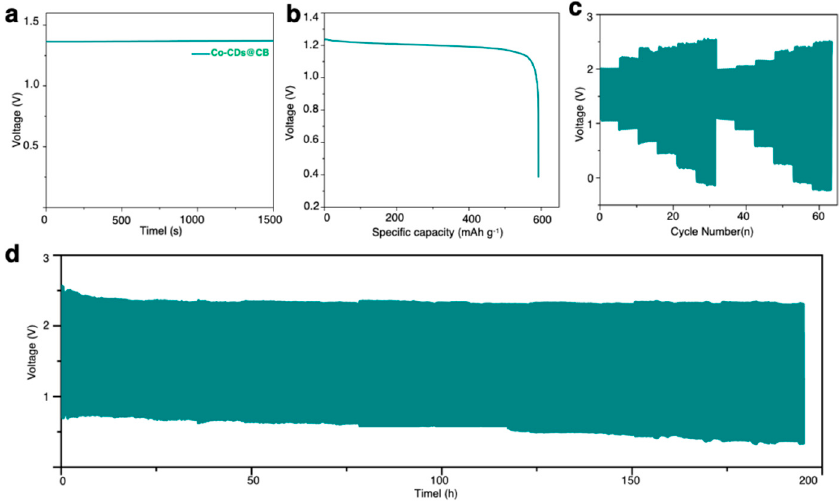
Figure 4. ( a ) Open-circuit curves plots. ( b ) Discharging capacity plots recorded under the current density of 10 mAcm − 2 . ( c ) Charge and discharge curves at various current densities (10, 20, 40, 60, 80, and 100 mA cm − 2 ). ( d ) Galvanostatic charge/discharge curves of a zinc–air battery at a current density of 10 mA cm − 2 .